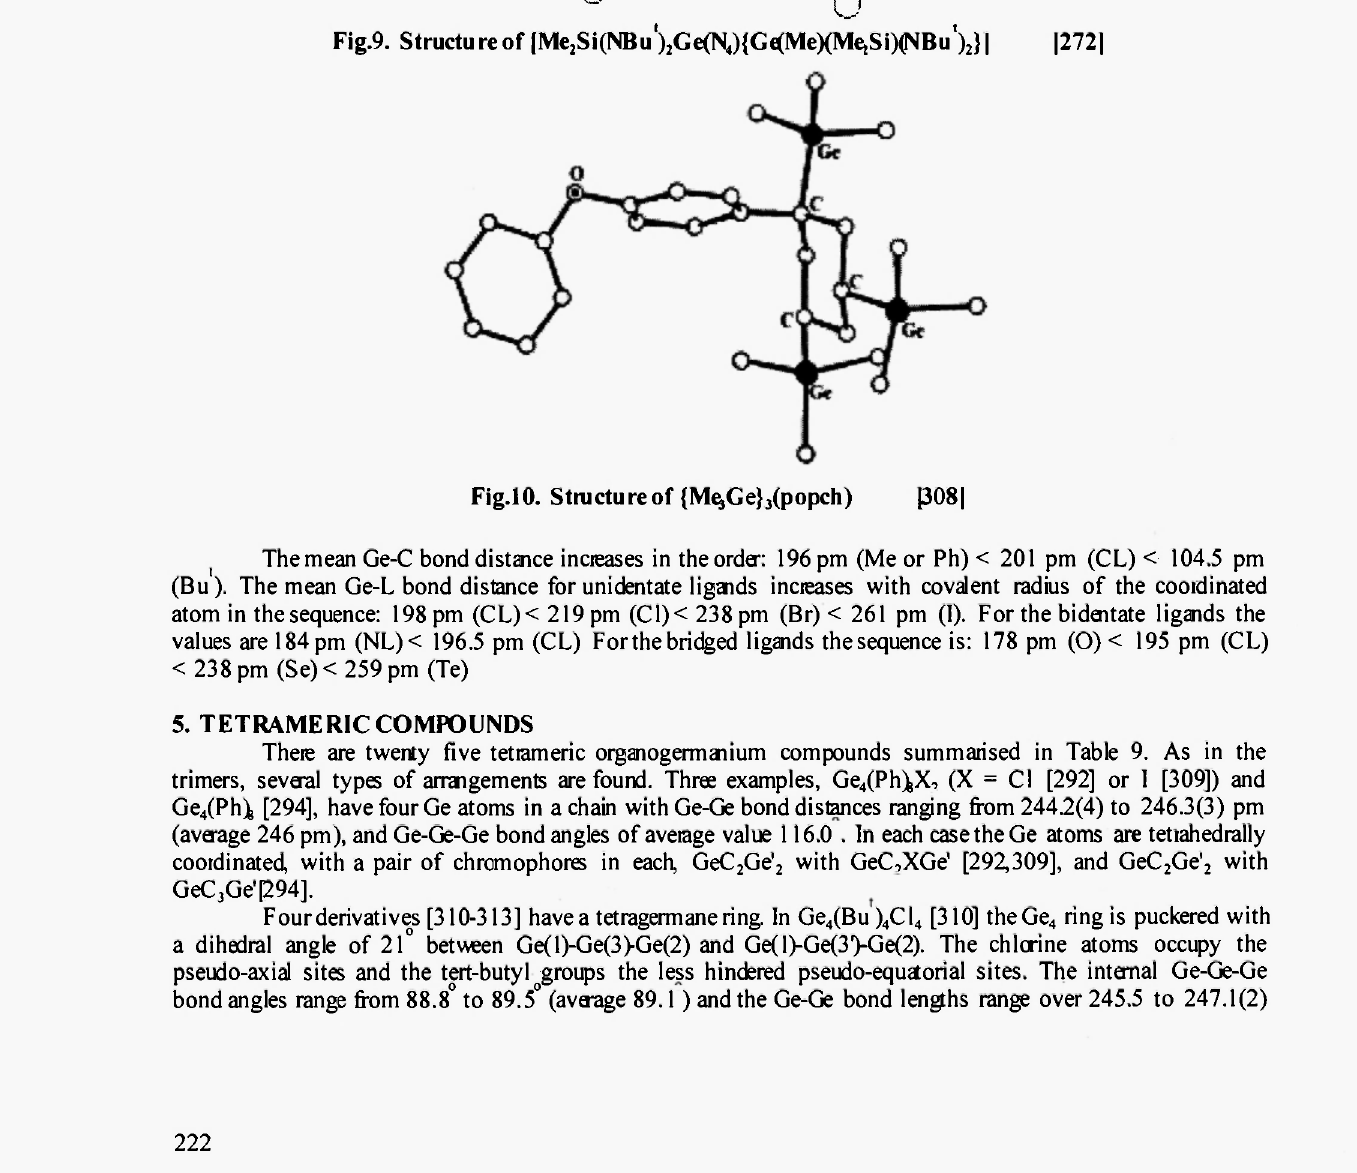
Fig.9. Structureof [Me 2 Si(NBu') 2 Ge(N 4 ){G<MeXMe ! Si)ÖVBu') 2 }| |272|